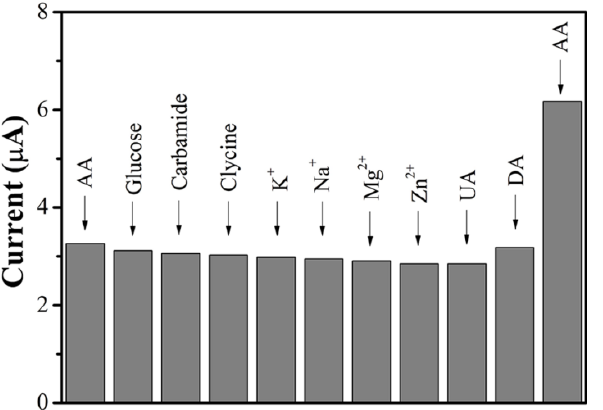
Figure 11. The amperometric response of the Bi 2 S 3 /rGO-3/GCE electrode towards the addition of 200 µM AA and various interfering compounds in 0.1 M PBS.